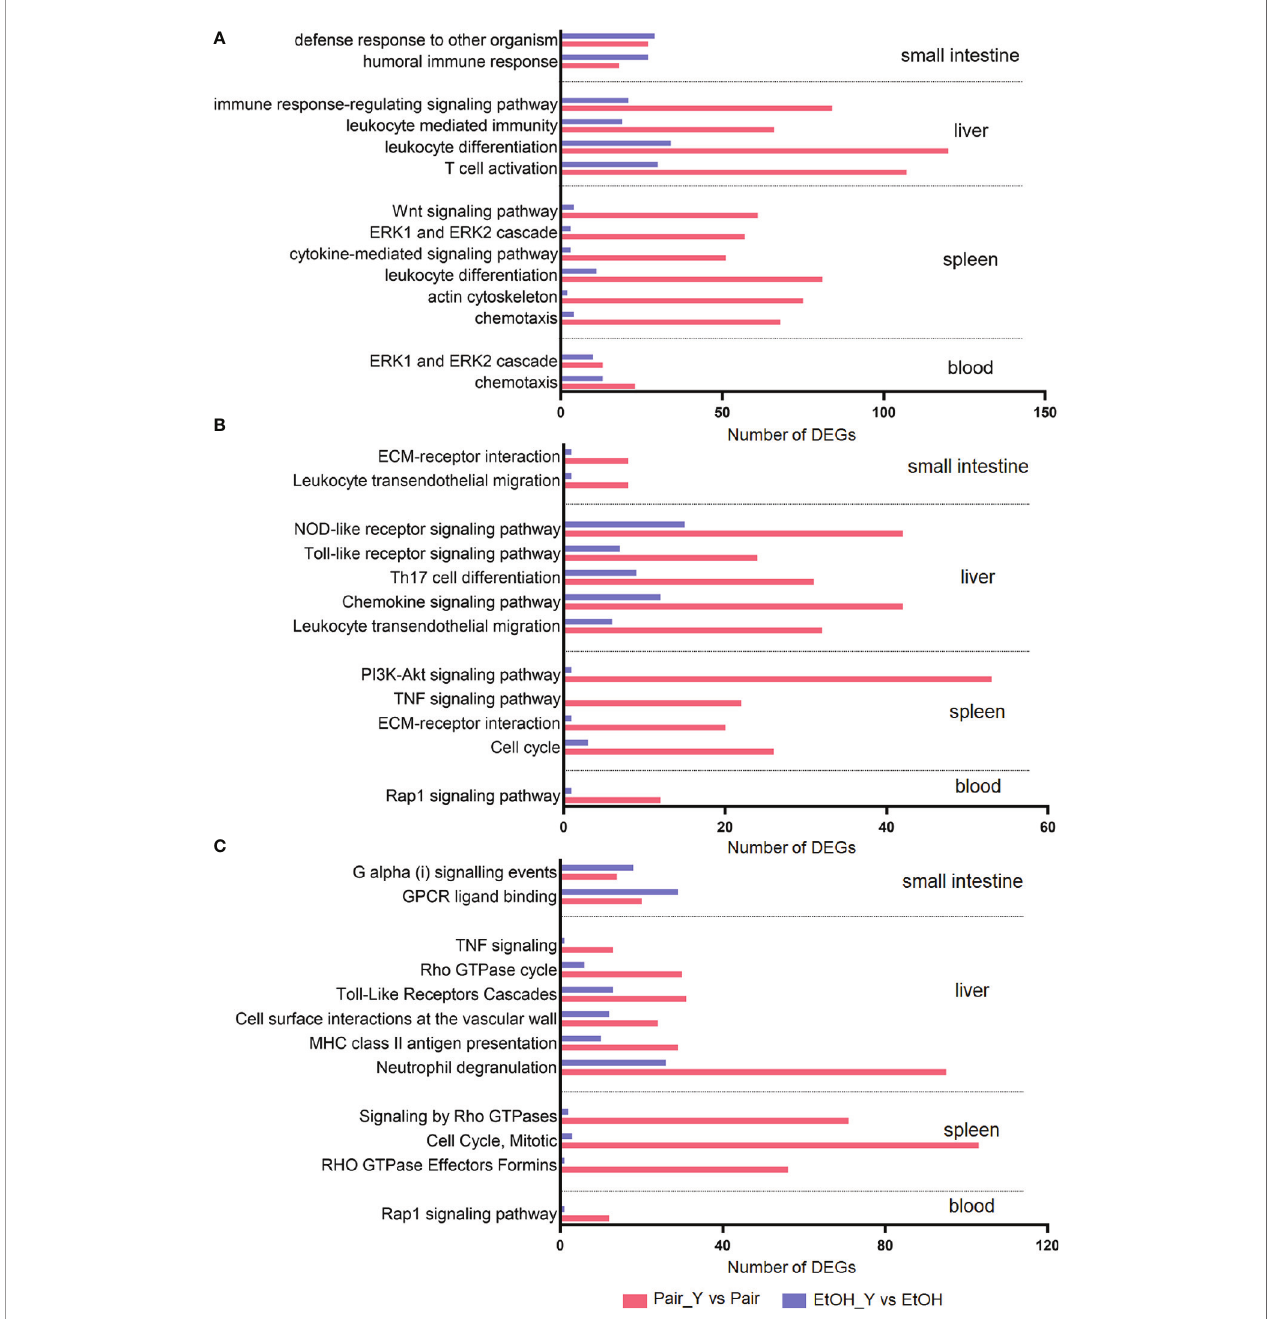
FIGURE 3 | GO (A) , KEGG (B) , and Reactome (C) annotation for DEGs. Bars represent the number of DEGs involved in the corresponding pathway. After YJ016 infection, the number of DEGs in the immune-related pathways in the Pair group was signi fi cantly higher than that in the EtOH group. The mean differences of three different methods were GO (45.69, P = 0.0003), KEGG (21.92, P < 0.0001), and Reactome (-31.33, P = 0.0082),